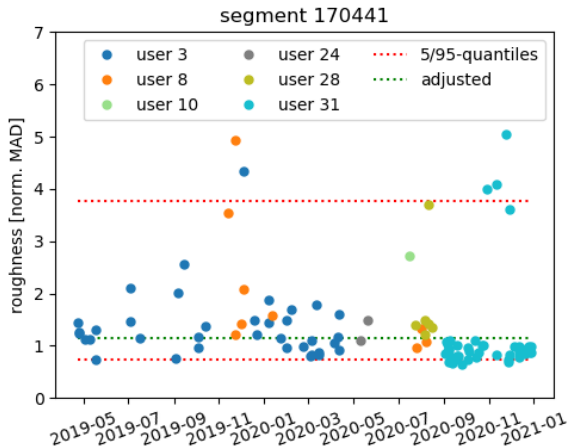
Figure 8. Plot of adjusted roughness observations over time for an exemplary street segment. The coarse outliers are assumed to result from incorrectly assigned observations, actually belonging to the parallel